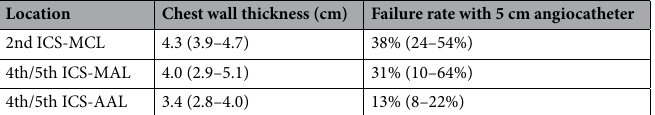
Table 2. Needle thoracostomy failure rate (modified from Laan et al., 2016) 25